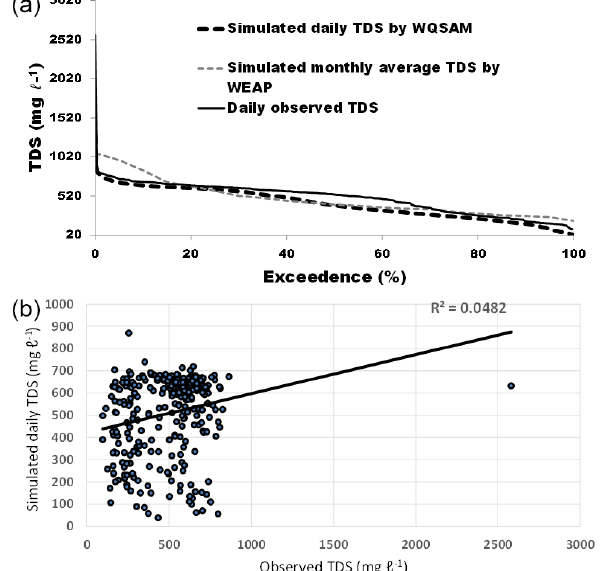
Figure 4. Frequency distribution of observed total dissolved solids (TDS), modelled daily TDS by the Water Quality Systems Assess- ment Model (WQSAM) and modelled average monthly TDS by the monthly-time-step Water Evaluation and Planning (WEAP) model (Sieber and Purkey, 2007) for the R20D catchment on the Buffalo River, Eastern Cape, South Africa. (b) X – Y plots of observed TDS and simulated TDS by WQSAM for the same